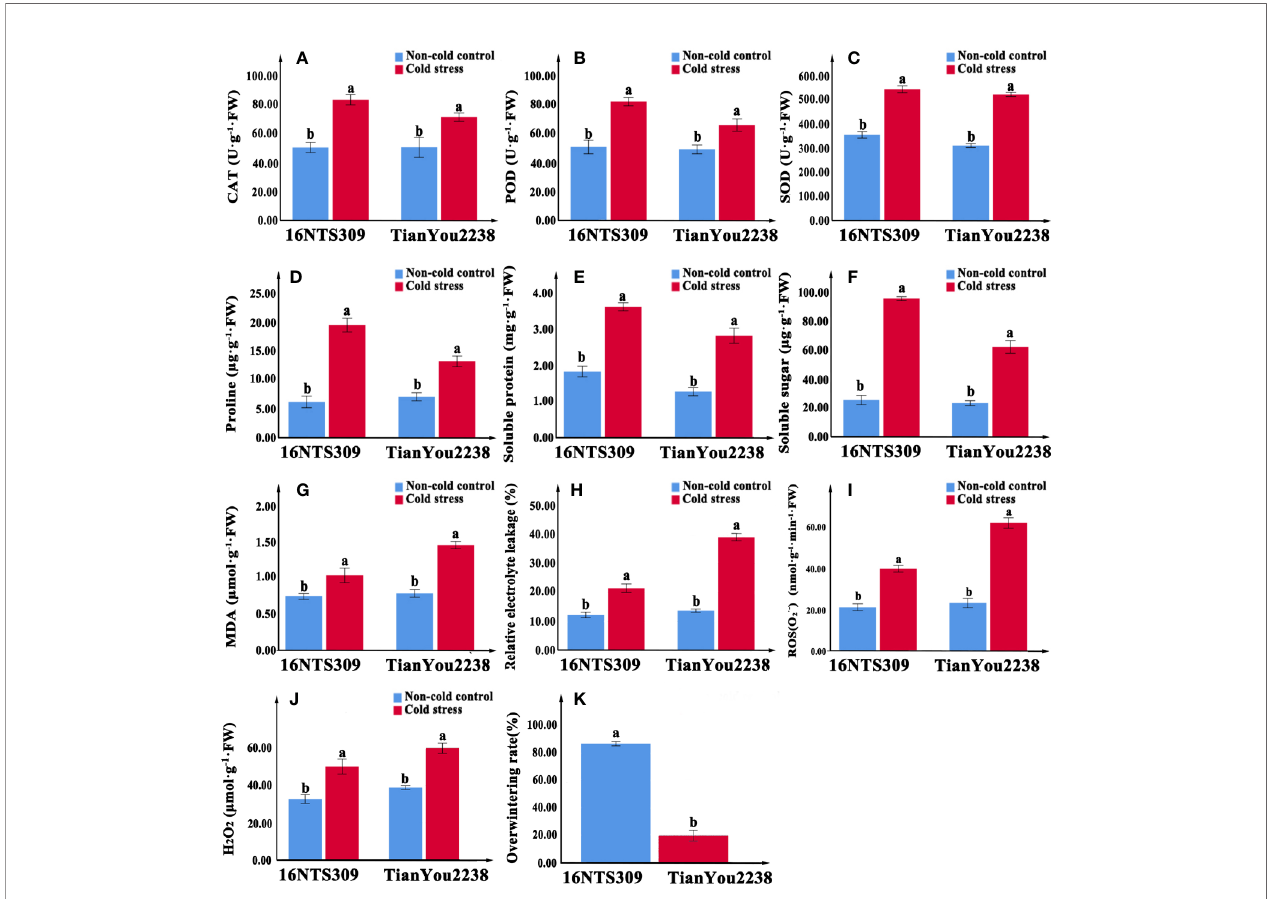
FIGURE 3 | The activity of catalase (CAT) (A) , peroxidase (POD) (B) , superoxide dismutase (SOD) (C) , proline (D) , protein (E) , soluble sugars (F) , malondialdehyde (MDA) (G) , relative electrolyte leakage (H) , O 2 − (I) , and H 2 O 2 (J) content accumulation in leaves of 16NTS309 and Tianyou2238 under cold stress at 4°C for 48h. Overwintering rates was recorded in natural environment. Average overwintering rstes (K) in plants of 16NTS309 and Tianyou2238 under harsh winter conditions. The majuscules indicate a signi fi cant difference (P<0.05) for the data of the cold stress treated samples compared with non-cold stressed samples. The different small letters indicate signi fi cant differences at p < 0.05. The mean values were calculated from three biological replicates. Error bars denote standard error of the